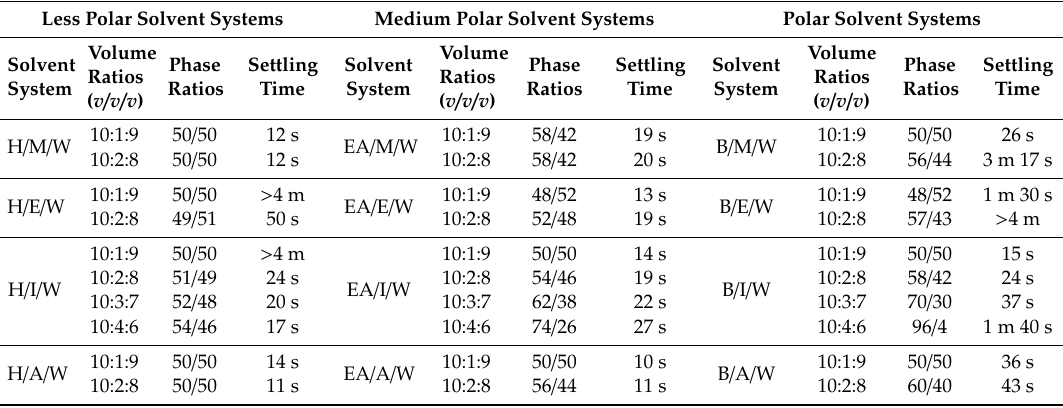
Figure 1. ( a ) Centrifugal partition chromatography (CPC) operation and chromatogram. Mobile phase composition with linear-gradient elution and ( b ) CPC separation chromatogram at 280 nm and scan mode: 254–320 nm. The details are described in Section 3.6. CPC procedure. Table 1. Phase ratios and settling times of each ternary biphasic solvent